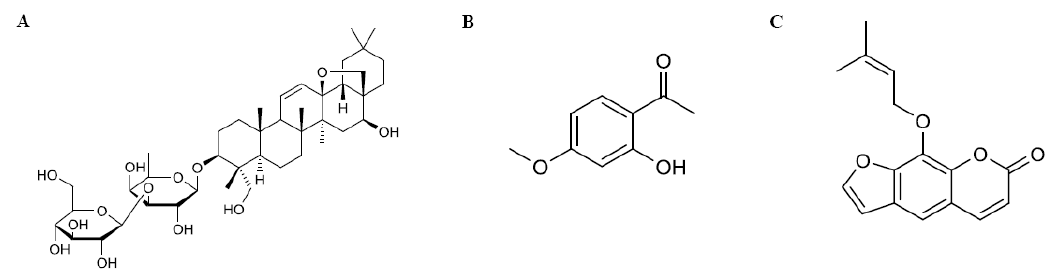
Figure 1. Chemical structures of three active/representative components in DA-9805: ( A ) saikosaponin a (SSa); ( B ) paeonol (PA); ( C ) imperatorin (IMP).